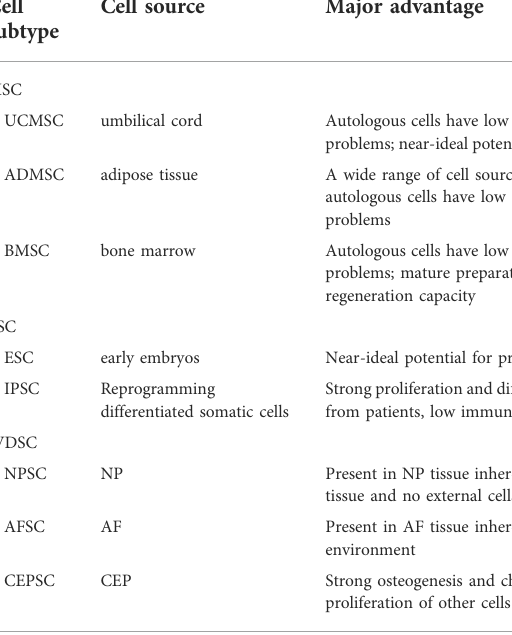
TABLE 1 Advantages and disadvantages of various stem